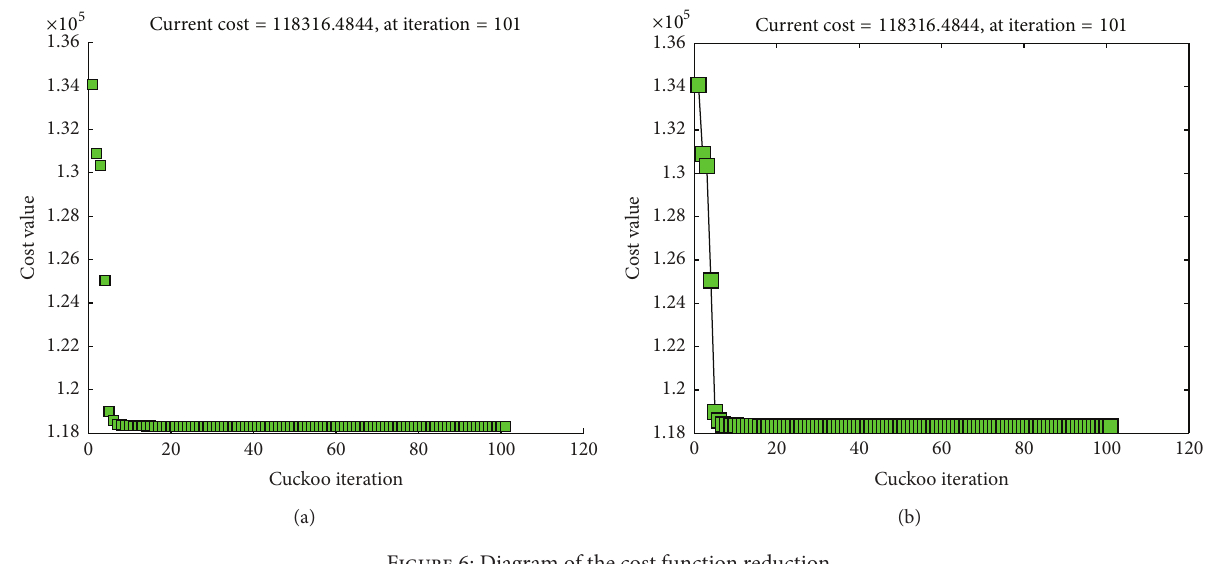
Figure 6: Diagram of the cost function reduction.